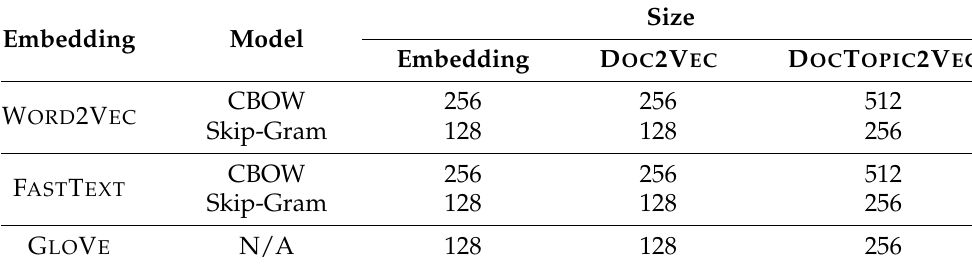
Table 1. Embedding